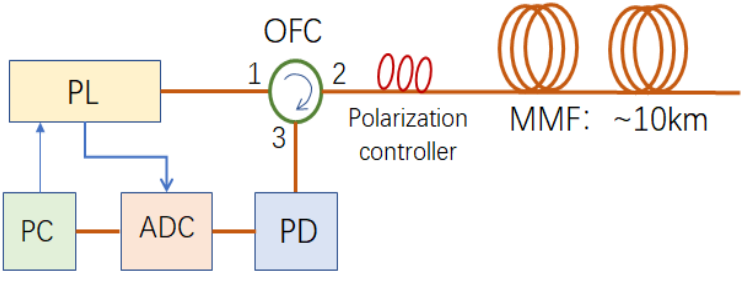
Figure 1. Schematic diagram of the experimental set-up.